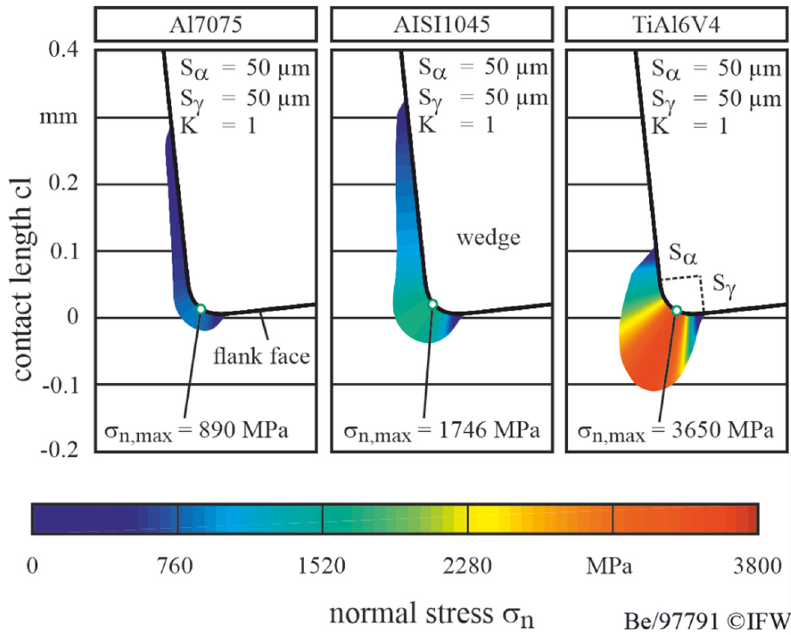
Figure 8. Simulated material specific normal stress distribution.